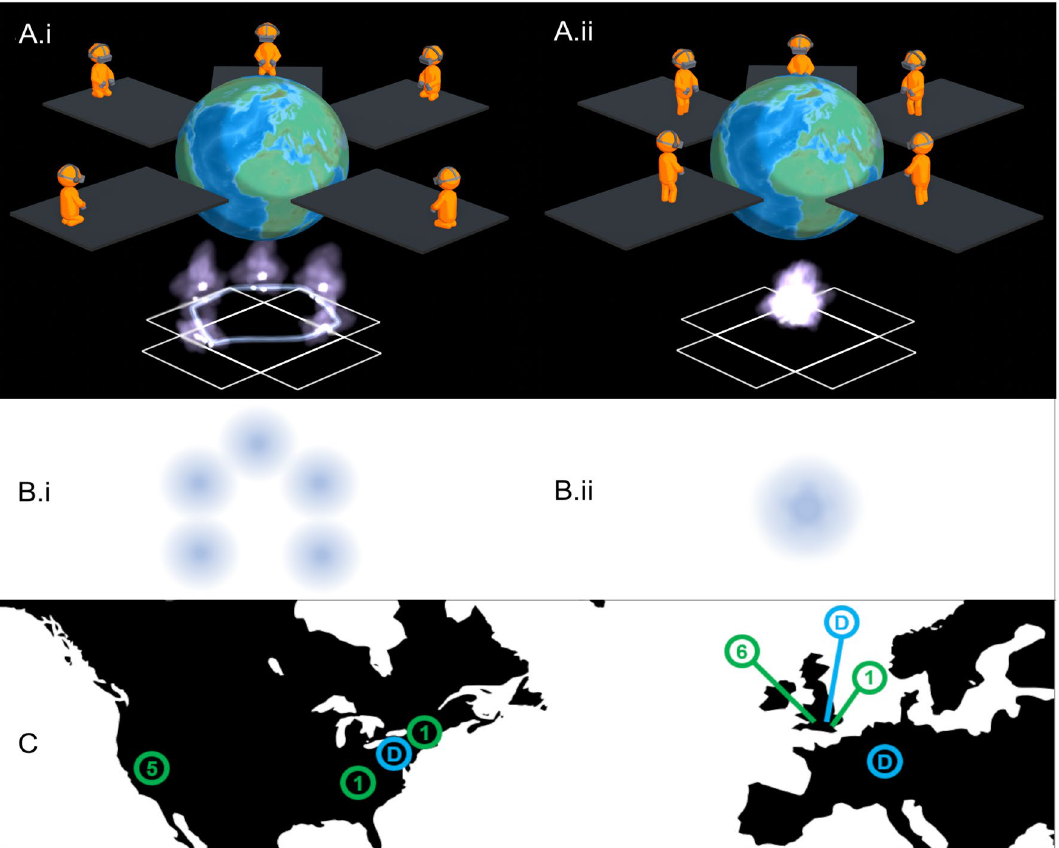
Figure 3. ( A.i ) shows 4 participants + 1 facilitator joining Isness from various ‘nodes’ distributed across the world. Participants are kneeling at the edge of their space and are represented in-world as energetic essences connected by a tangible dynamical molecular thread (which they ‘hold’ in their hands). ( A.ii ) shows participants undertaking ‘energetic coalescence’. Standing at the center of their respective mats, their energetic bodies overlap as they occupy the same position in the shared virtual space. The pattern on the floor in ( A.i ) and ( A. ii ) shows how participants’ local ‘play spaces’ were oriented within the virtual space. ( B.i ) & ( B.ii ) show IOS diagrams corresponding to ( A.i ) and ( A.ii ), for analogy with Fig. 1. ( C ) shows the international Isness ‘node’ locations as circular markers labelled with the total number of nodes in that location. There were 5 nodes